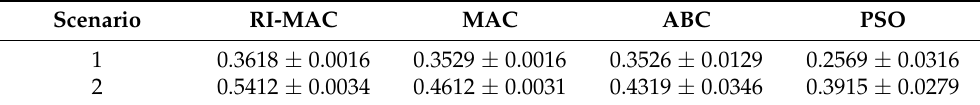
Table 6. Fitness values of four algorithms under two scenarios.